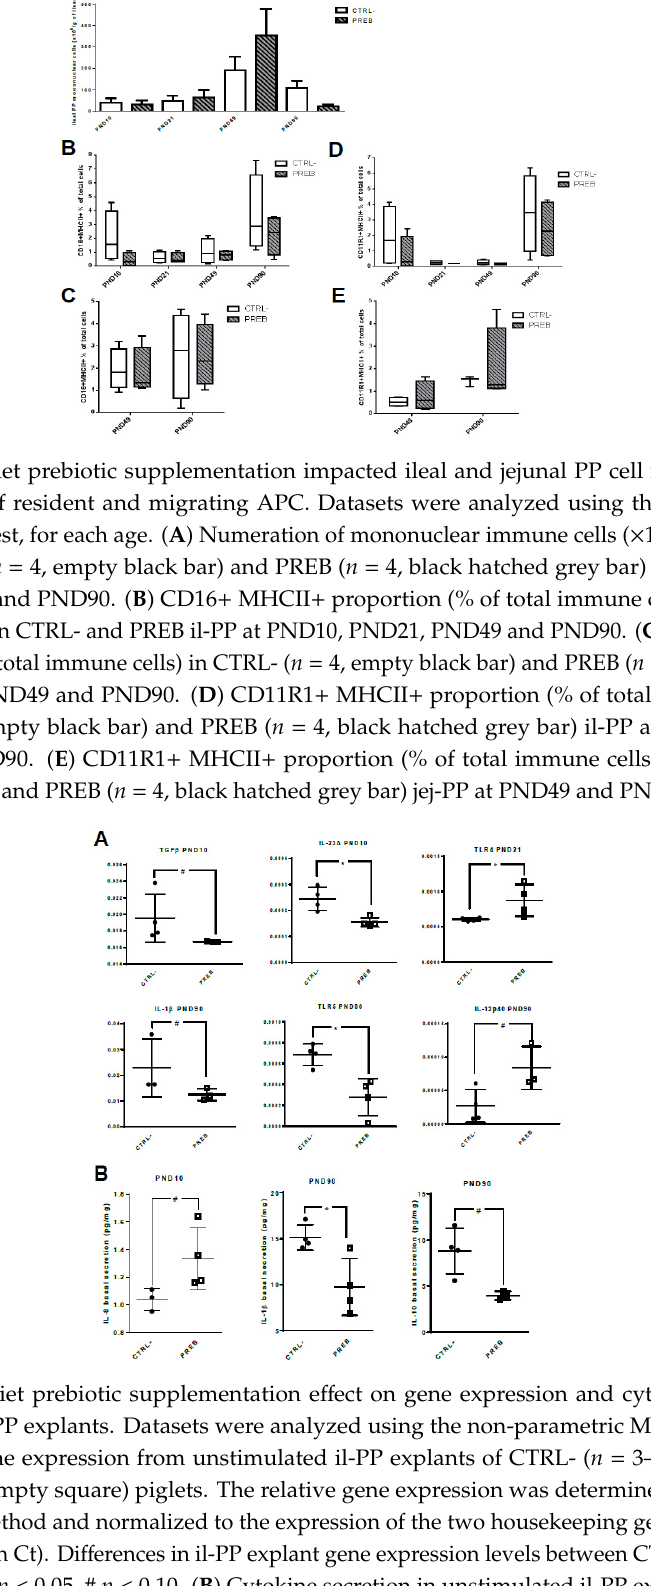
Figure 3. Piglet performance. Normally distributed data were analyzed using a two ‐ way ANOVA performing time, diet and the interaction between these two factors, followed by Tukey’s multiple comparison tests when appropriate ( A ) Piglet death proportion (% of the litter size) from PND3 to PND9 after force ‐ fed gavage with DON (DONgav) compared to control (CTRL ‐ ) and maternal supplementation with DON (DON). # means difference at p = 0.06 between DONgav and the two other groups (CTRL ‐ and DON). ( B ) Piglet body weight (kg) from birth to PND49. Time, diet and the interaction time x diet were highly significant ( p < 0.0001). DONgav piglet body weights (empty grey circle) were lower than CTRL ‐ (full black circle) and DON piglets (full black triangle) (* p < 0.0001). ( C ) Body weights of piglets CTRL ‐ (full black circle) and PREB (empty black square) recorded from birth to PND49 were not different.